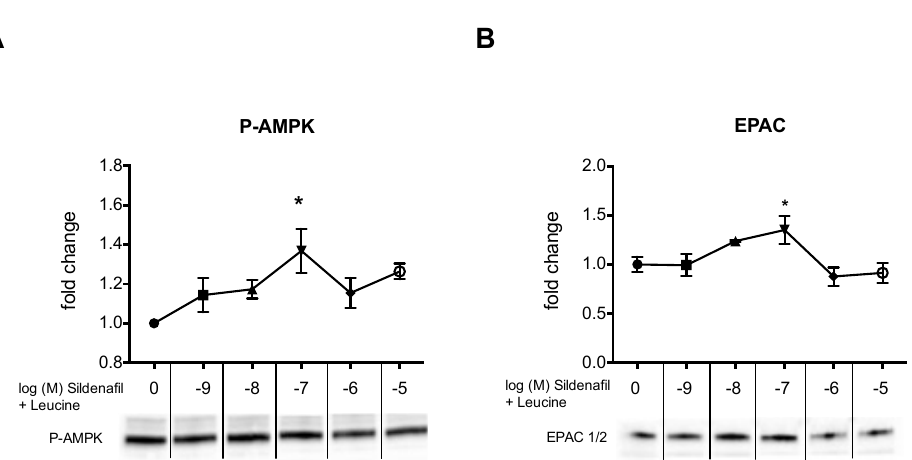
Figure 4. Protein expression of Phospho (Thr172)-AMPK and EPAC in 3T3L1 adipocytes. ( A ) P-AMPK and ( B ) EPAC protein expression in 3T3L1 cells treated with sildenafil (1 nM to 10 µM) in combination with leucine (0.5 mM) for 2 hours. Graphs were calculated from pooled densitometry measurements of two different blots ( n = 4) and representative blots are shown. * indicates a significant difference from the control ( p < 0.05).